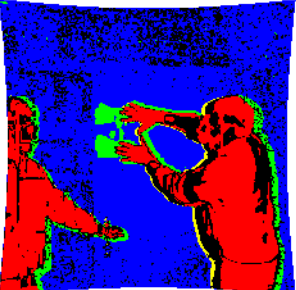
Figure 13: Results of rule-based classification based on logical operators: a clear distinction between background (blue), people (red), passive scene manipulation (yellow) and active scene ma- nipulation (green) is possible. Note that passive and active scene manipulation are also detected at edges which indicates a small error in the